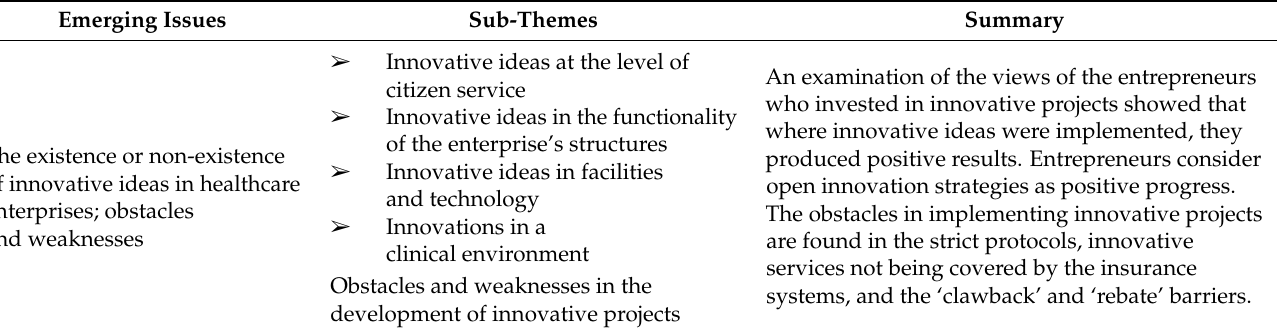
Table 2. Emerging issues and sub-issues in relation to